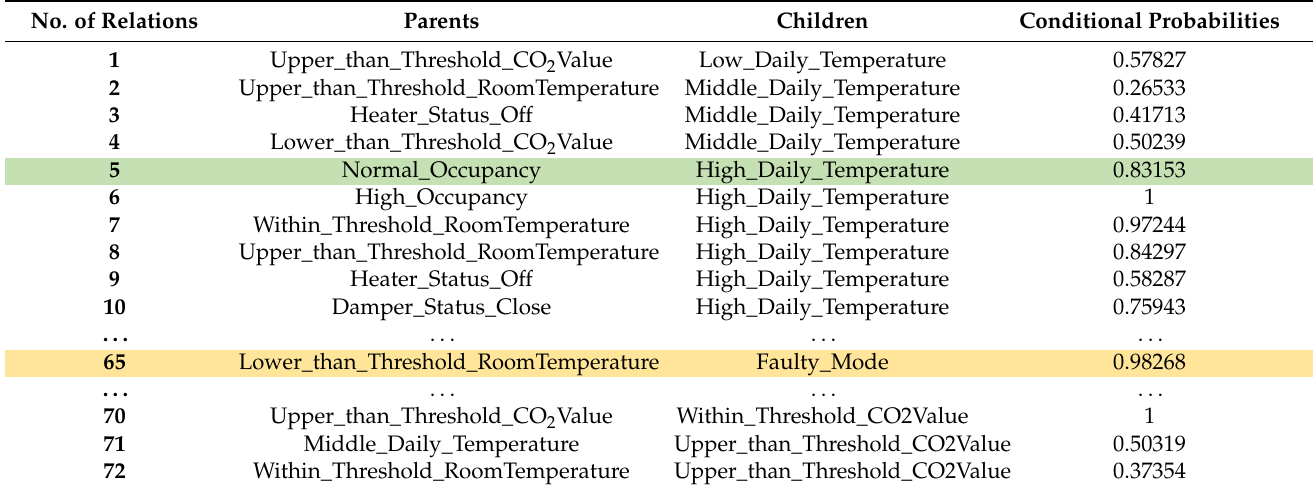
Table 20. Use-case Relation Direction Probability (RDP) for CO 2 sensor fault.